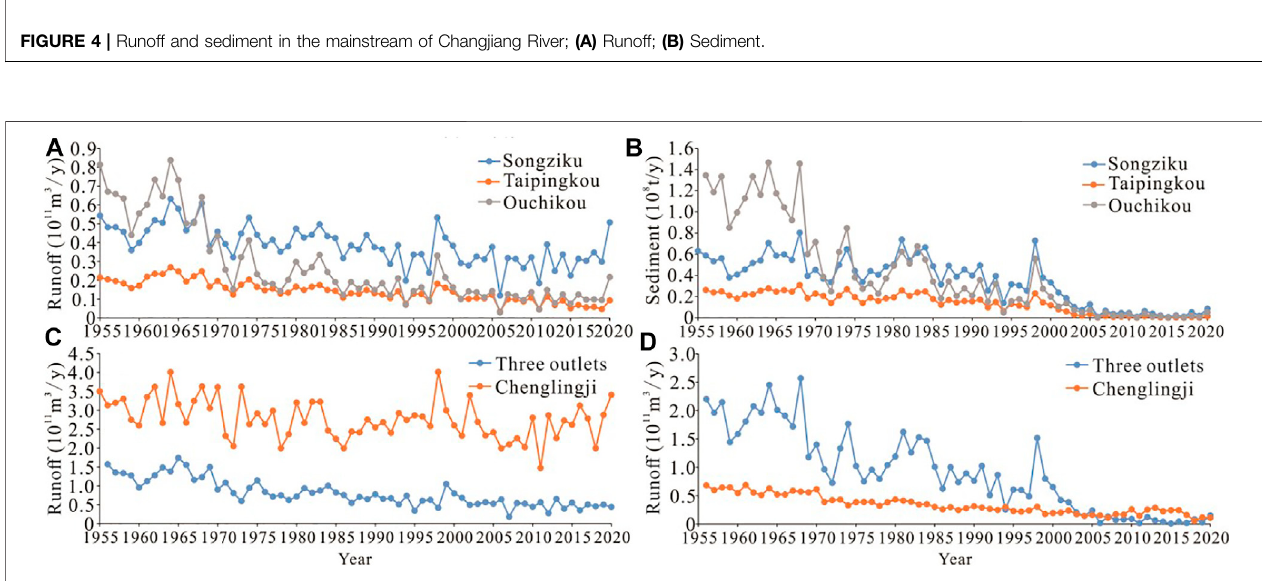
FIGURE 5 | Three outlets diversion relationship of Dongting Lake; (A) Runoff of Songzikou, Taipinghkou, and Ouchikou; (B) Sediment of Songzikou, Taipinghkou, and Ouchikou; (C) Runoff of three outlets and Chenglngji of Dongting Lake; (D) Sediment of three outlets and Chenglngji of Dongting Lake.